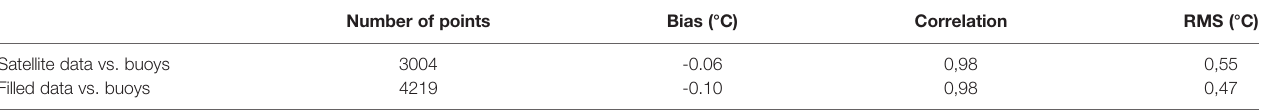
TABLE 1 | Bias (°C), correlation and root mean square error (RMS, °C) calculated between original satellite SST and SST from in situ buoys and between the reconstructed SST fi eld with DINEOF and the SST from the